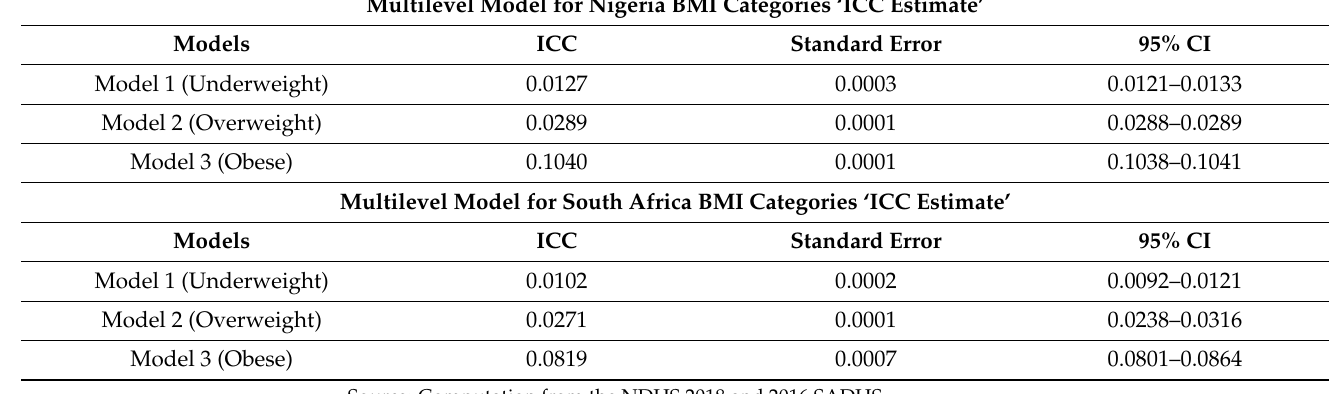
Table 7. ICC for body weight among women of childbearing age in Nigeria and South